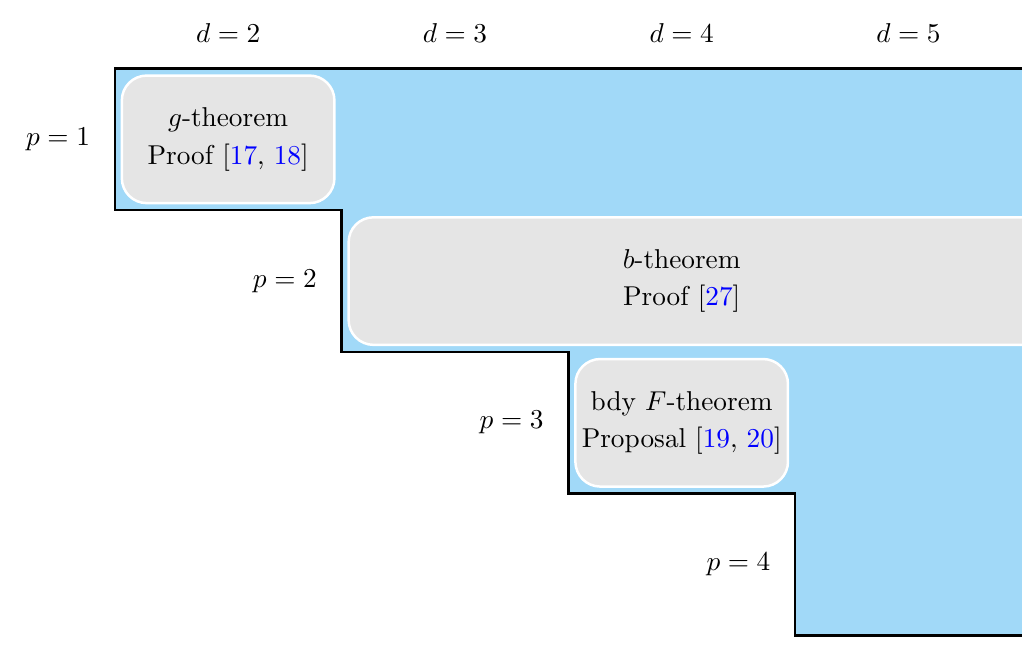
Table 1 . Summary of the conjectured and proved C -theorems in BCFTs and DCFTs. Our proposal reduces to the known ones in the shaded regions and provides new ones in the region colored in light